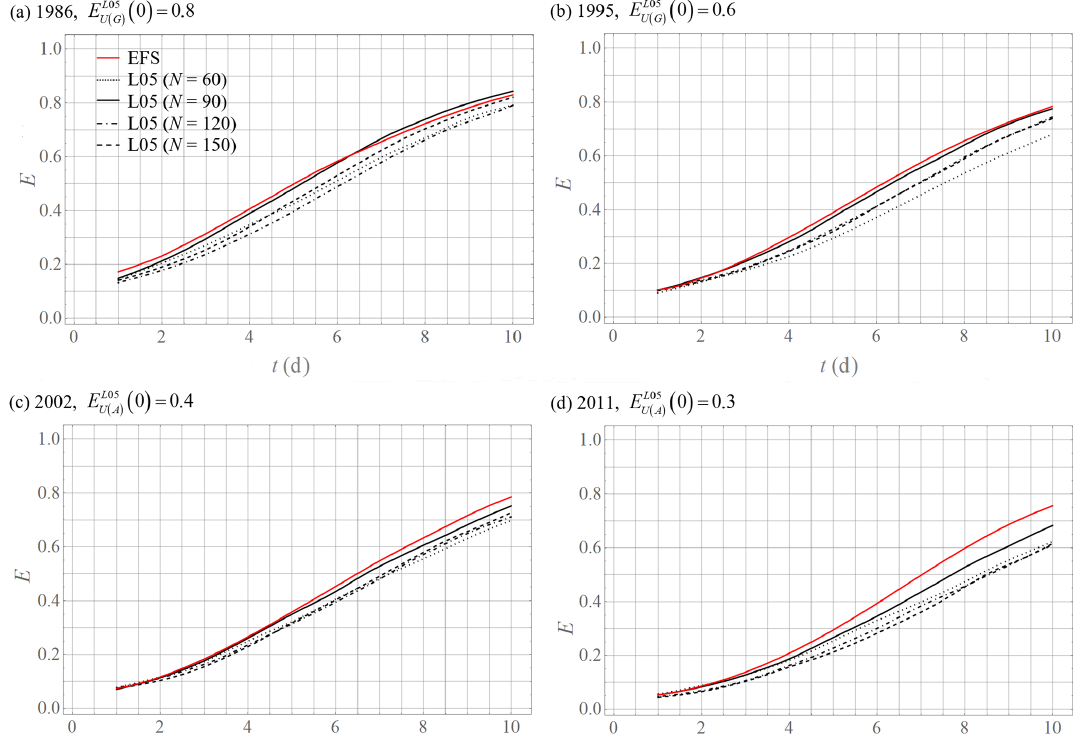
(Eq. 15) (EFS; ,U (Table 2) (L05; geometric means ,U